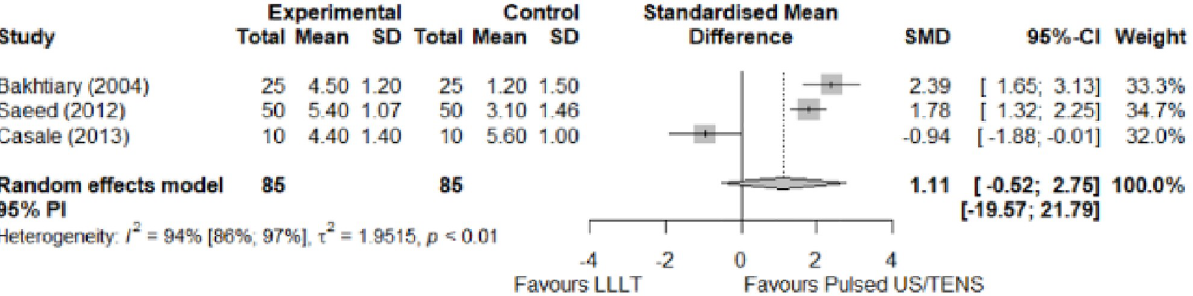
Fig 20. Analysis—Comparison between electrophysical modalities